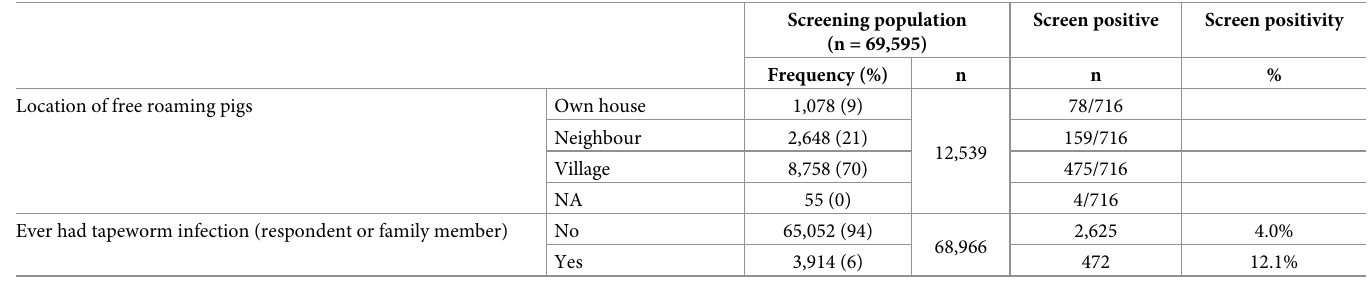
(s) depended on the criterion fulfilled. The proportion of screened positive confirmed with epileptic seizure(s) was highest for criteria 1 to 3 (Table 3). The proportion of screened positive confirmed with epileptic seizures was higher if another person answered the questionnaire.